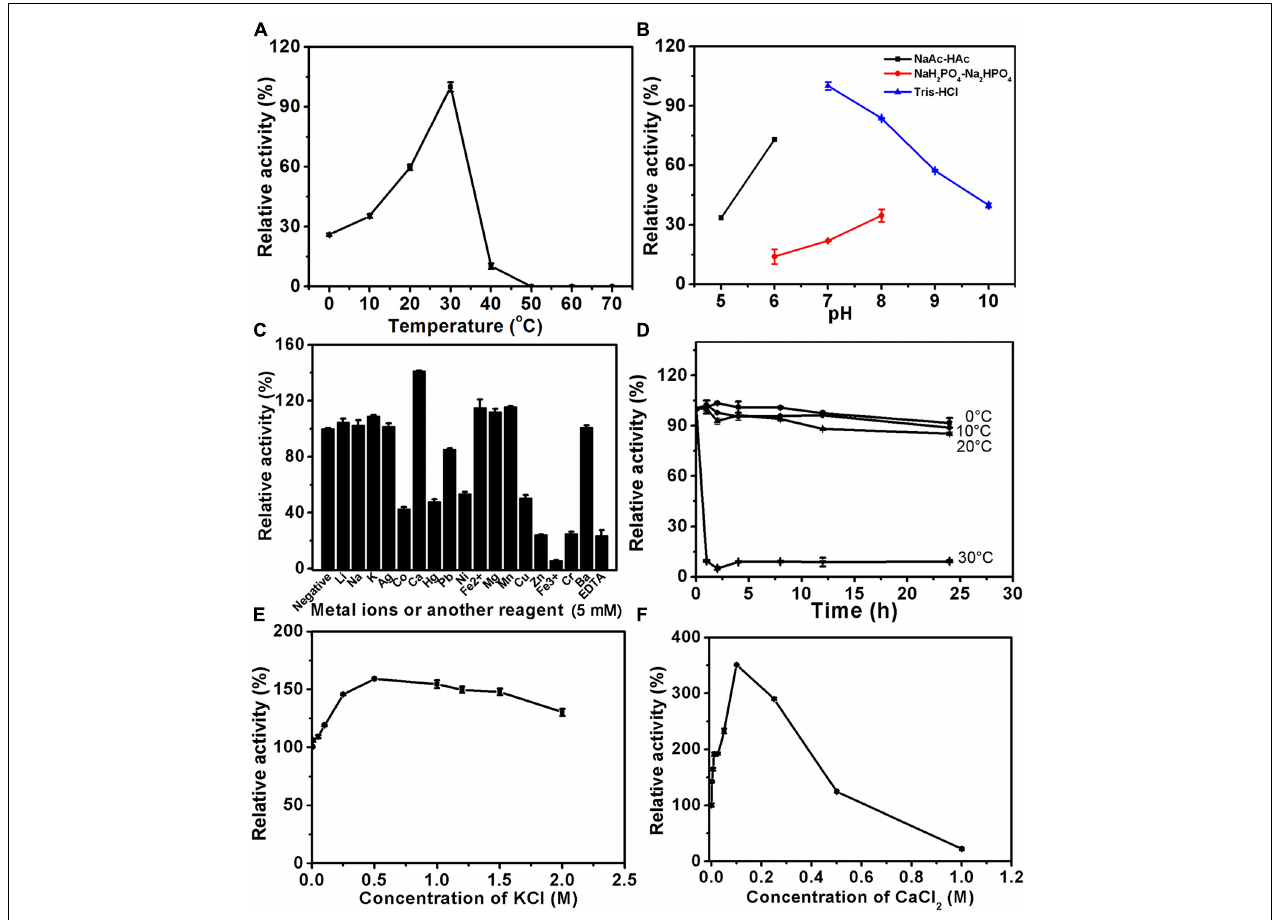
FIGURE 5 | Biochemical characteristics of PB_3285. The biochemical characteristics of PB_3285 were investigated using disaccharide (cid:49) C (1 mg/ml) as substrate as described under section “Materials and Methods.” (A) The effects of temperature on the activity of PB_3285 were determined at 0–70 ◦ C and the activities were presented as relative values calculated by comparing with the highest (100%) obtained at 30 ◦ C. (B) The effects of pH were determined in buffers (NaAc-HAc buffer, NaH 2 PO 4 -Na 2 HPO 4 buffer and Tris-HCl buffer) with different pH values from 5 to 10 and the activities were presented as relative values calculated by comparing with the highest obtained in the 50 mM Tris-HCl buffer (pH 7.0). (C) The effects of metal cations were measured in Tris-HCl buffer (pH 7.0) containing 5 mM various metal ions and the activities were presented as relative values calculated by comparing with the highest obtained in Tris-HCl buffer (pH 7.0) only. (D) The thermostability of PB_3285 was estimated by preincubating this enzyme in 50 mM Tris-HCl buffer (pH 7.0) at temperatures from 0 to 70 ◦ C for 0–24 h followed by measuring residual activities. (E) The effects of K + concentration on the activity of PB_3285 were assayed in Tris-HCl buffer (pH 7.0) containing 0–2 M KCl and the activities were presented as relative values calculated by comparing with that obtained in the buffer without K + . (F) The effects of Ca 2 + concentration were measured in Tris-HCl buffer (pH 7.0) containing 0–1 M CaCl 2 and the activities were presented as relative values calculated by comparing with that obtained in the buffer without Ca 2 + . Error bars represent means of duplicates ±